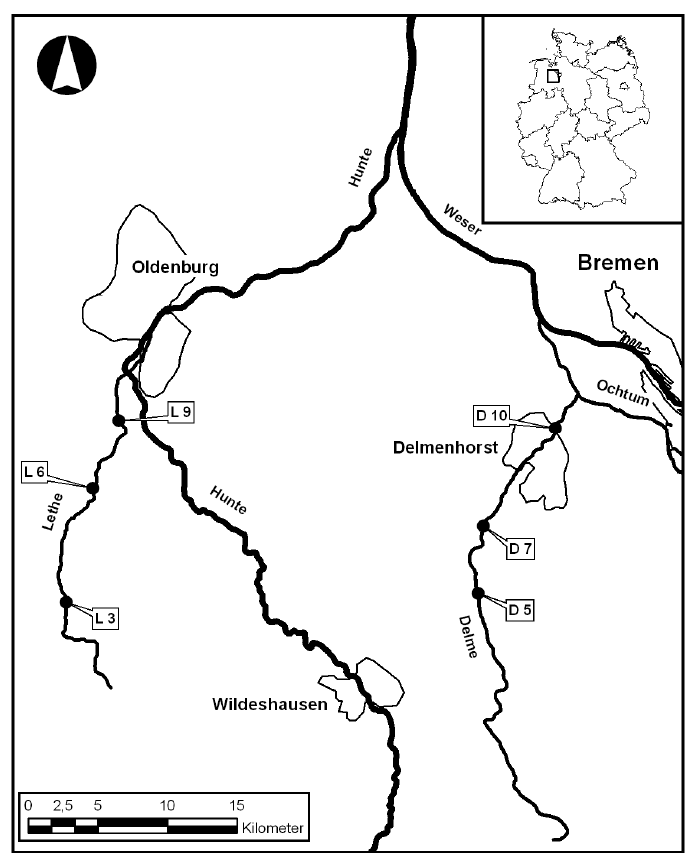
Figure 1. German river network with sampling